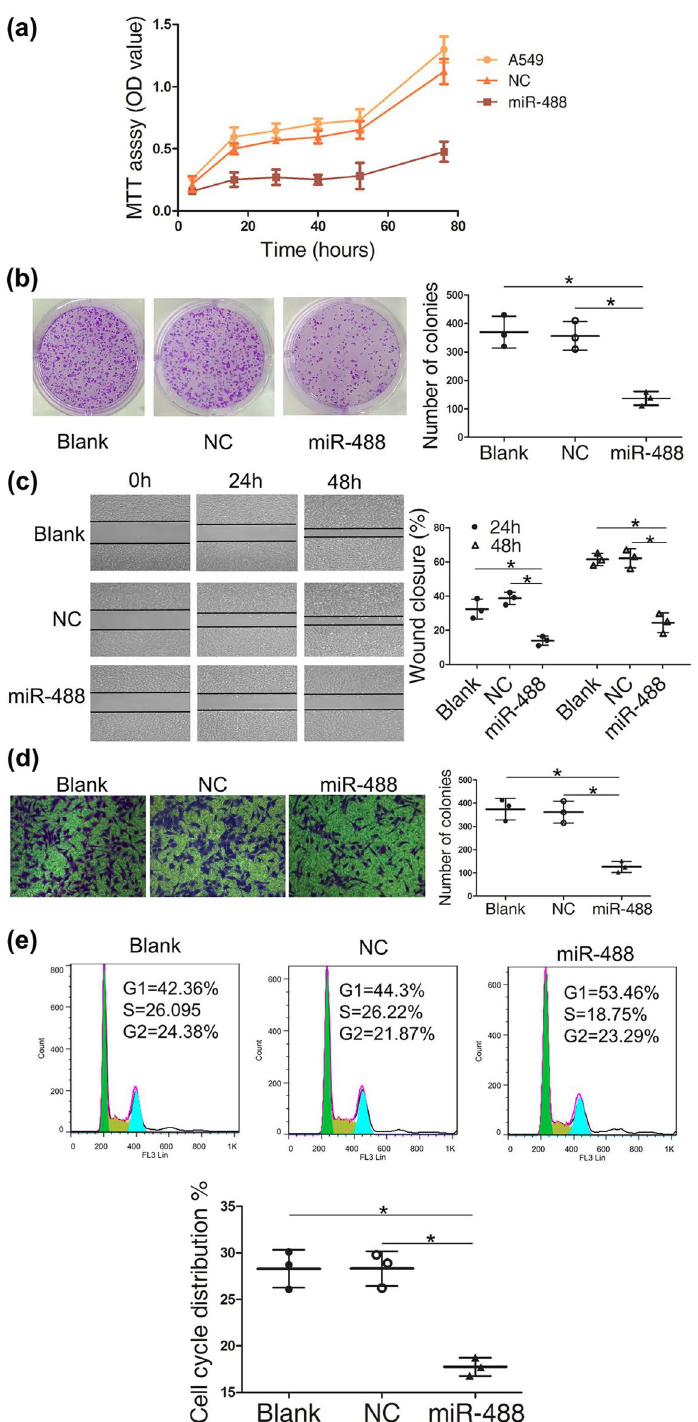
Figure 4. The A549 cell line and cells transfected with negative control (NC) and the miR-488 mimic were used in the following assays. Cell viability ( a ) was tested with an MTT assay, and colony formation ( b ) was measured with crystal violet staining. All these showed that miR-488 could inhibit the proliferation of A549 cells. Wound healing ( c ) and transwell assays with Matrigel ( d ) were tested in A549 cells with miR-488 overexpression. The percent of wounds closed or number of cells migrating through the membrane were counted and are compared in the diagrams. The cell cycle ( e ) was evaluated with flow cytometry. The data from three independent experiments are given as the mean ± SD (*P <